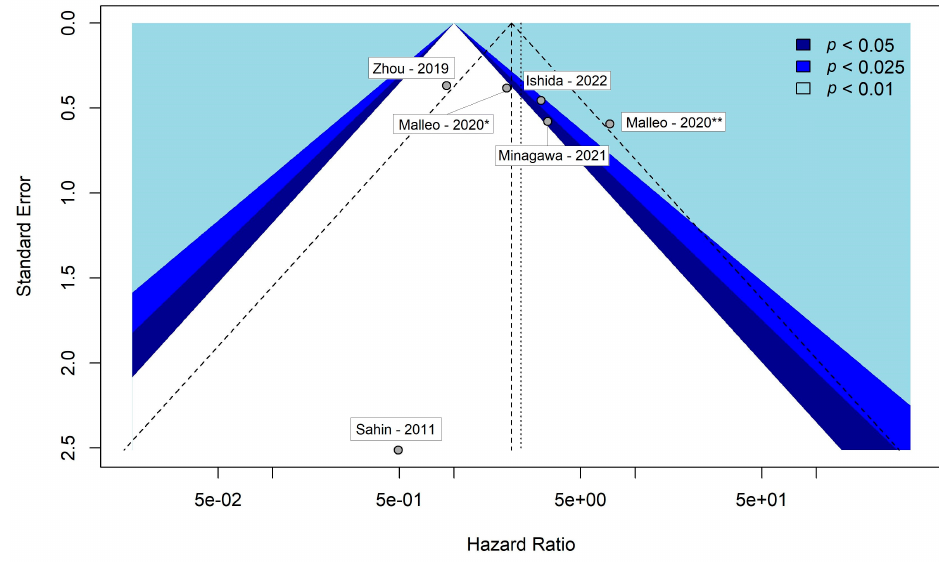
Figure 5. Contour-enhanced funnel plot of publication bias. * LN station 9; ** LN station 8.